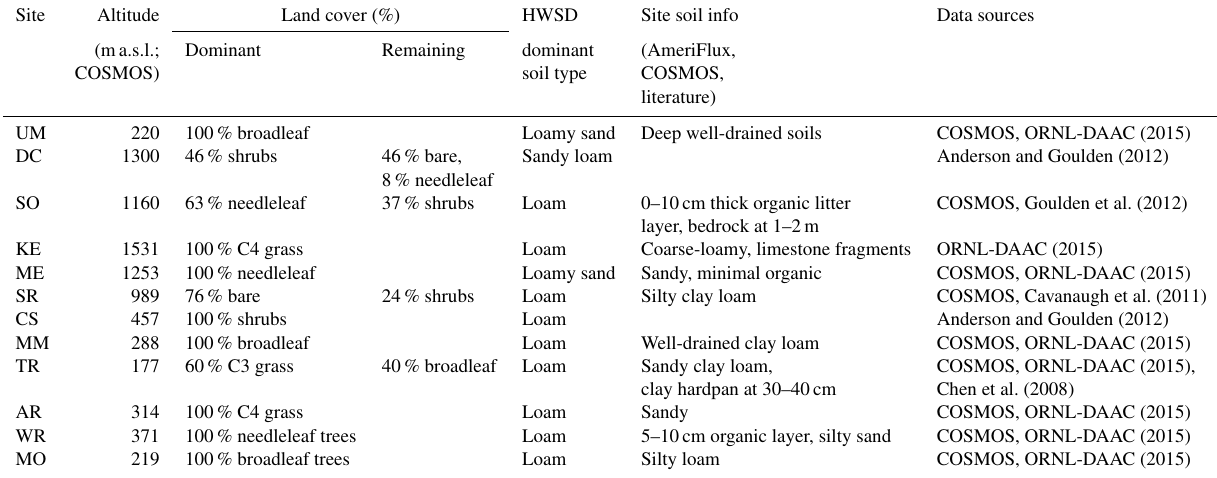
Table 1. Site characteristics. Altitude from the COSMOS website, land cover percentages from AmeriFlux and publications. Harmonised World Soil Database (HWSD) data were used to define default model parameter values (here only soil categories shown). Site Altitude Land cover